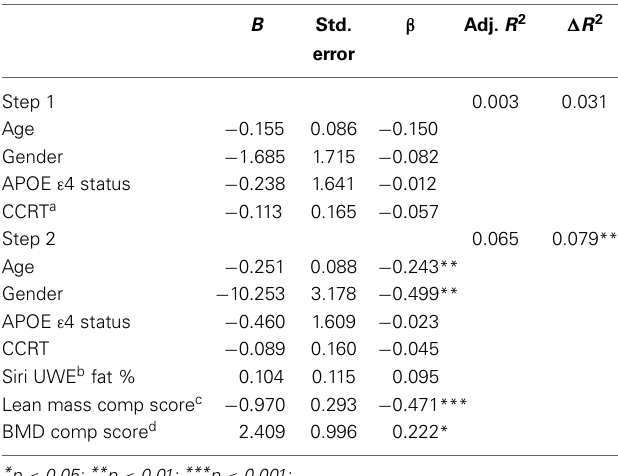
Table 5 | Hierarchical linear regression predicting baseline CVLT discriminability score from lean mass and bone density composite scores. B